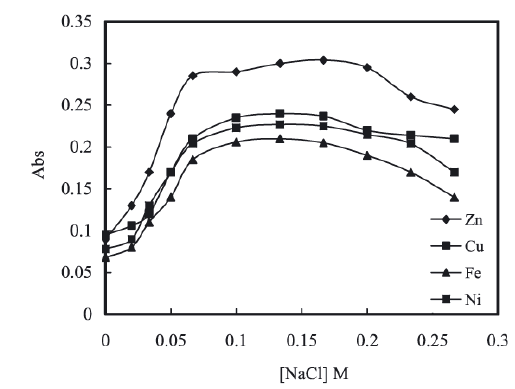
Figure 4. Effect of salt concentration on CPE of analyte